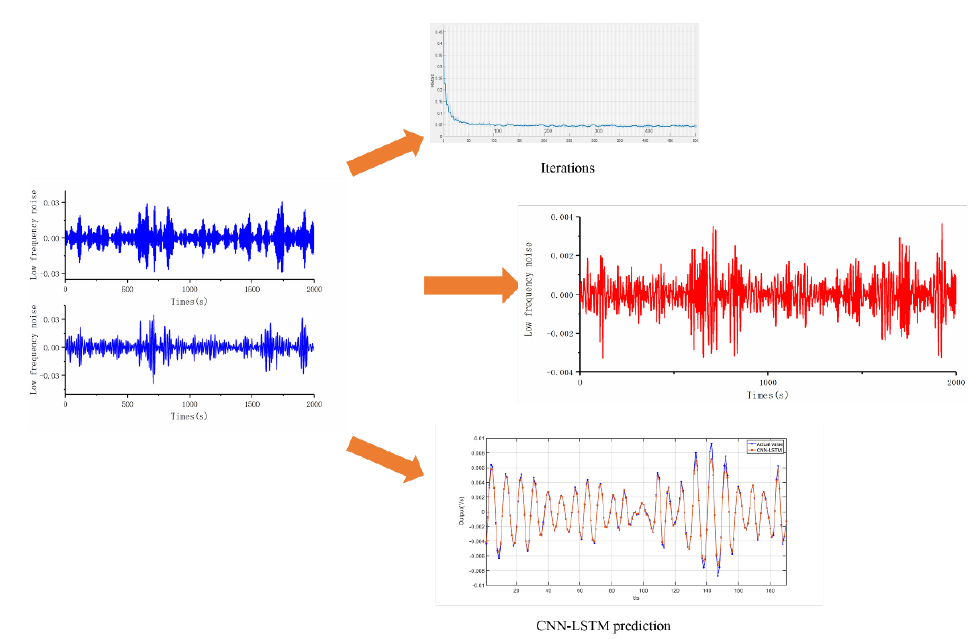
Figure 18. Noise denoising based on CNN-LSTM (60 ◦ C– − 40 ◦ C).